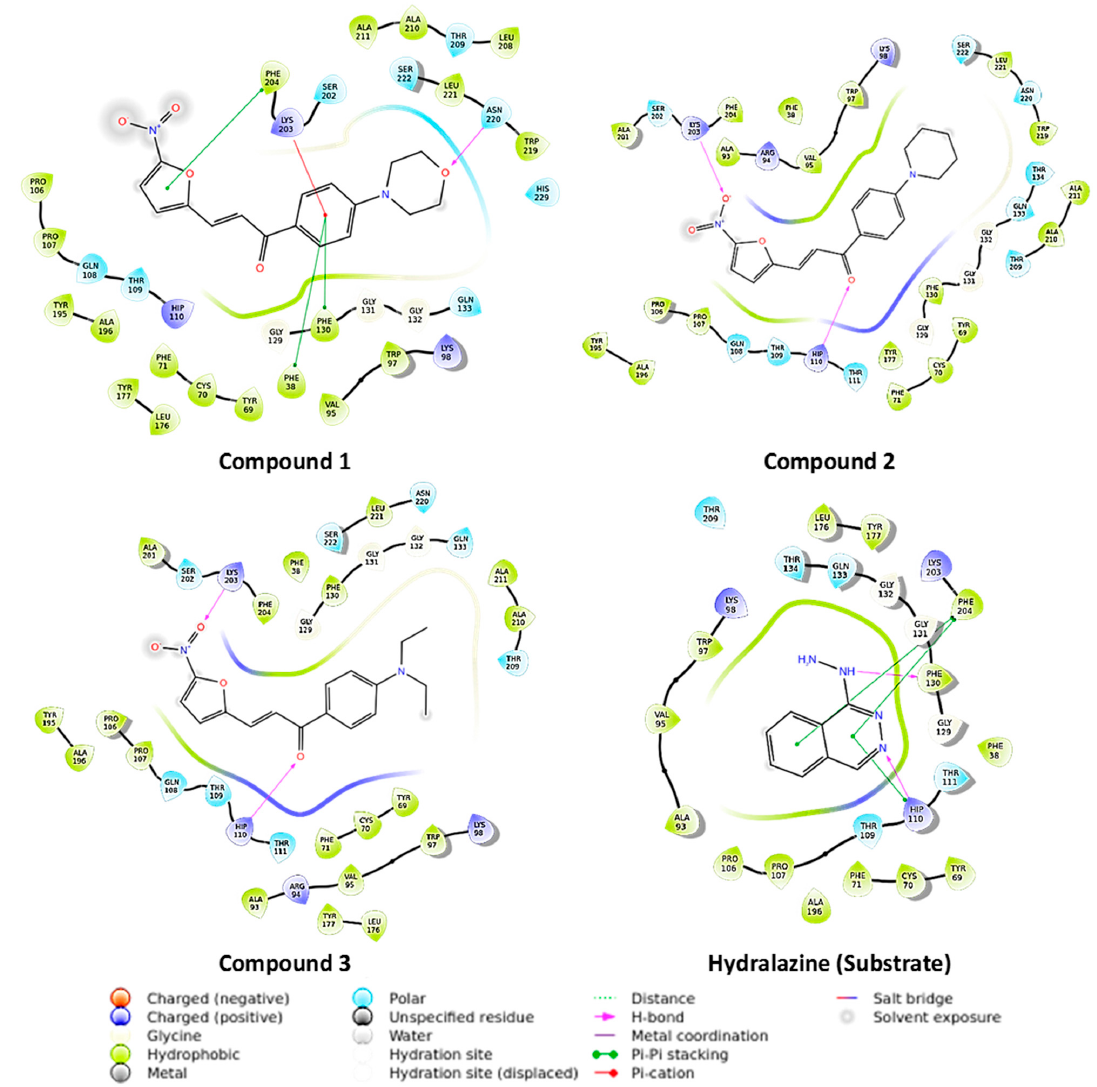
Figure 2. 2D representation of molecules docked in Mycobacterium tuberculosis N -acetyltransferase (TBNAT) (PDB: 4BGF). The docking study was carried out using the Grid-based Ligand Docking with Energetics (GLIDE) module of the Maestro molecular modelling suite, Schrödinger LLC, NY.